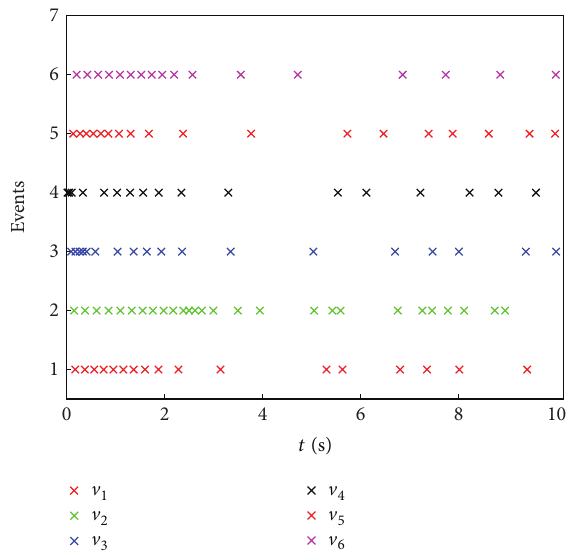
Figure 3: Event-triggering instants of each agent with double- integrator dynamics.